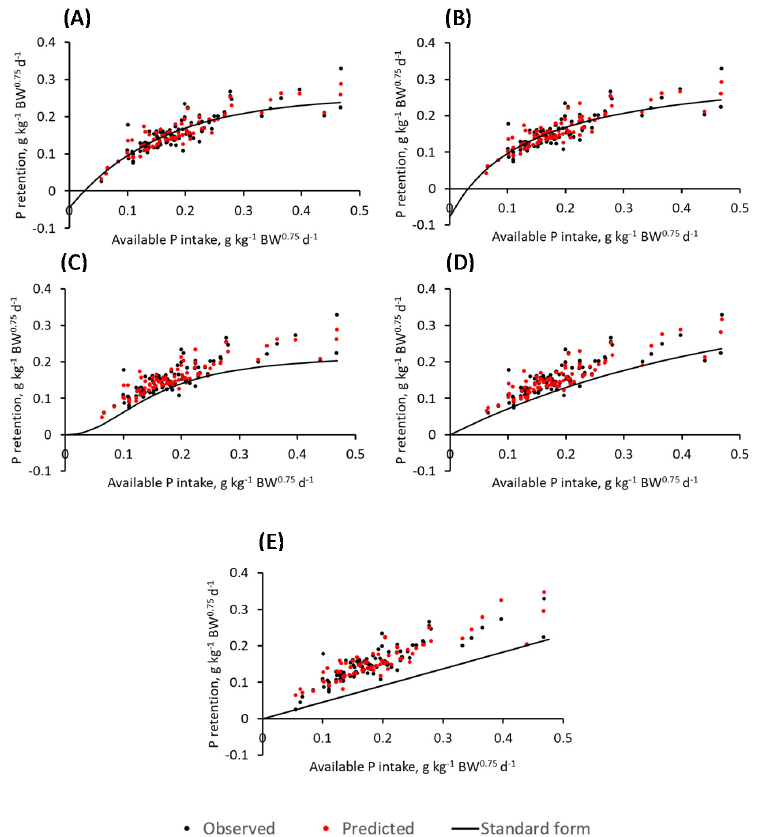
Figure 1. Observed and predicted values resulting from fitting the monomolecular ( A ), Michaelis-Menten ( B ), Morgan ( C ), Richards ( D ) and linear ( E ) to the available P intake dataset. Predicted values represented by the red markers include the random effect of study while the black solid line represents predicted values of the standard equation forms, viz. Equations (1)–(5) using the parameter estimates from Table 2.